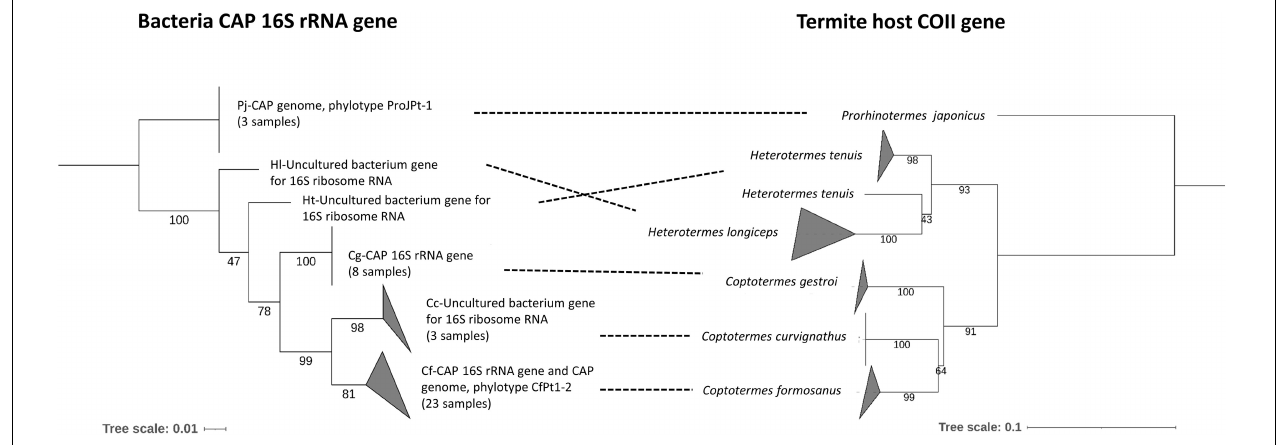
FIGURE 3 | Phylogenetic tanglegram of CAP related bacteria strain and termite hosts. The bacteria tree is a condensed version of Figure 2 . The topology of the termite tree was estimated by maximum-likelihood analysis of the cytochrome oxidase II (COII) genes. Dashed lines connect the same termite host species. Node support values were obtained from 1,000 bootstrap replications. A detailed reference sequence list was submitted in Supplementary Table 3